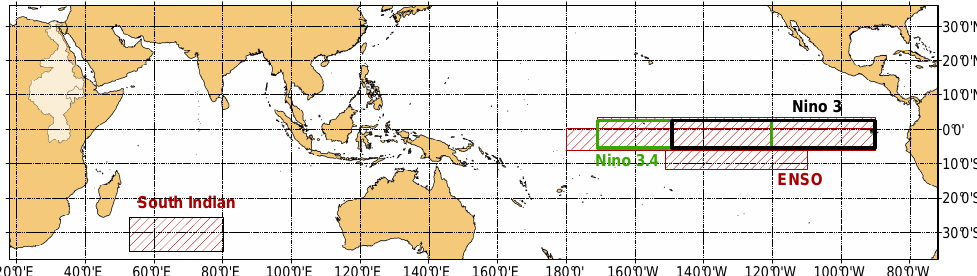
Figure 3. World map showing areas that cover the ENSO and northern and southern Indian Ocean SST indices. El Niño 3 and 3.4 are outlined in black and green, respectively. The whole Nile basin is outlined in